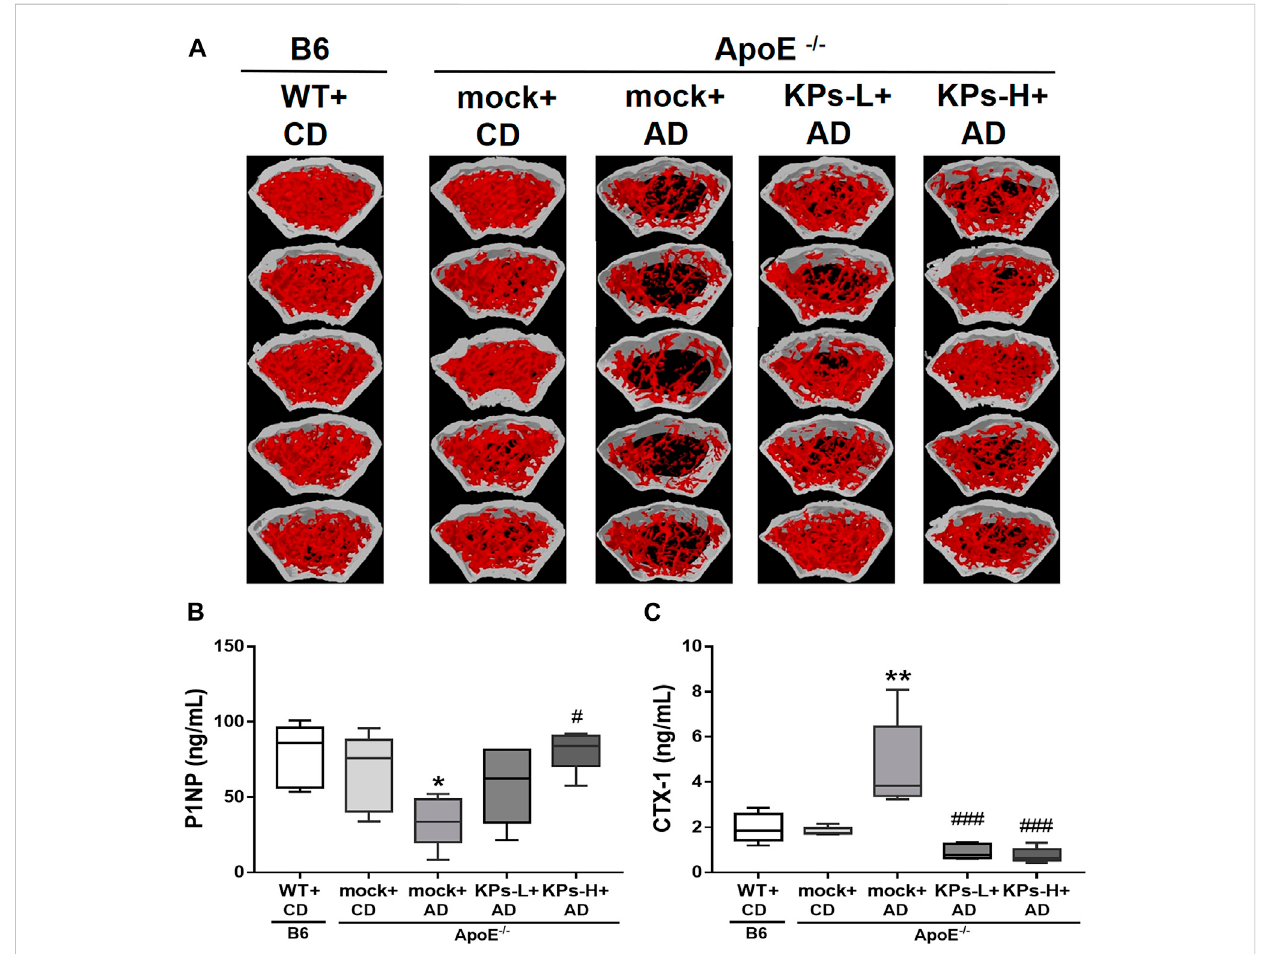
FIGURE 6 Effects of KPs on femurs (A) and on the serum bone formation marker P1NP (B) and resorption marker CTX-1 (C) . Statistical signs ( n = 5): * p < 0.05, ** p < 0.01 vs. WT + CD/B6, and # p < 0.05, ### p < 0.001 vs. mock + AD/ ApoE − / − .